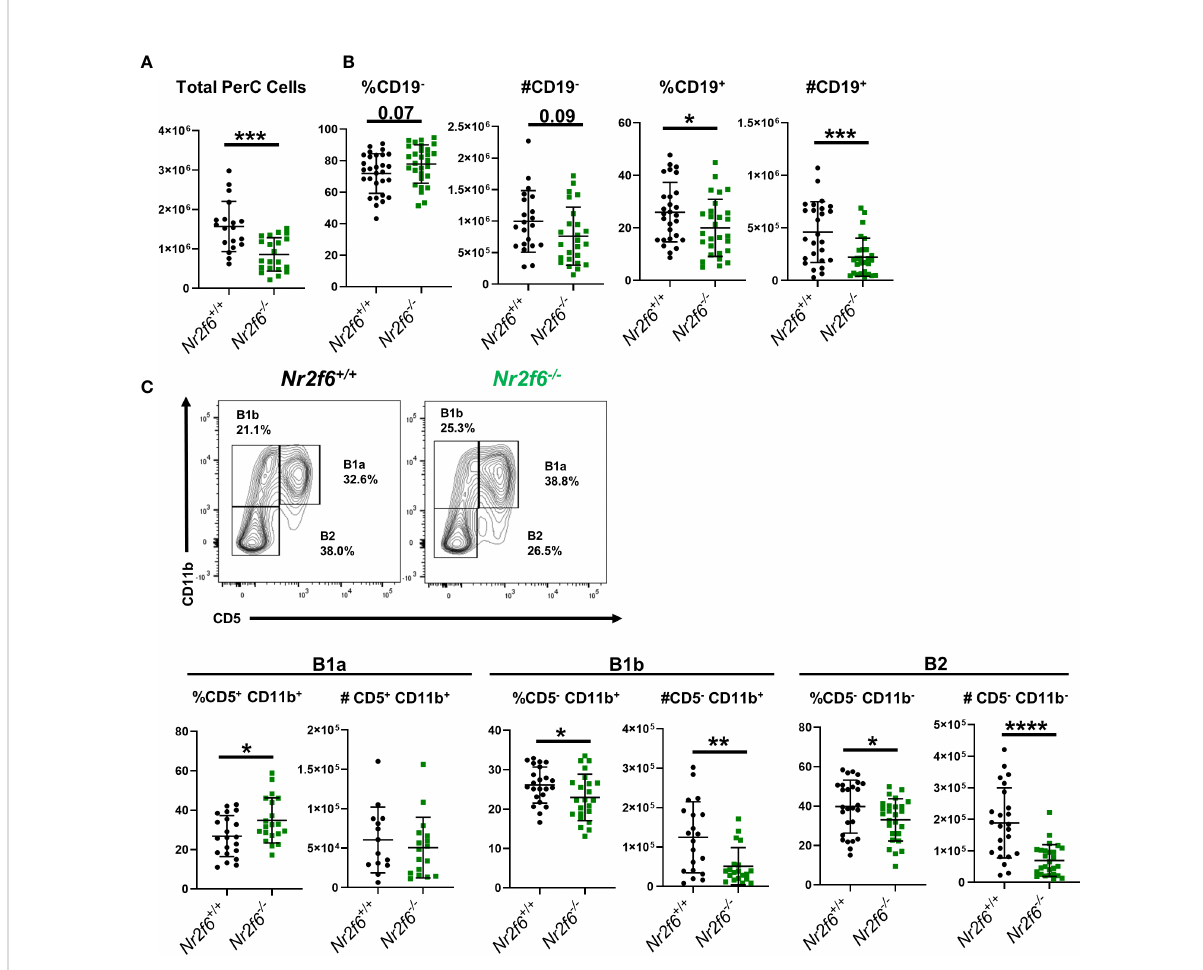
FIGURE 1 Germ-line Nr2f6 -de fi ciency results in lower B1b and B2 cell numbers in the peritoneum. (A) Total peritoneal cells were enumerated after peritoneal lavage from Nr2f6 +/+ and Nr2f6 -/- mice. (B) Percentage and total numbers of CD19 + and CD19 - cells were determined by fl ow cytometry. (C) B1a, B1b and B2 cell populations were further de fi ned by fl ow cytometry using the markers CD5 and CD11b. Flow data was used to calculate total numbers of each B cell population. Each data point represents an individual mouse, data are from at least fi ve